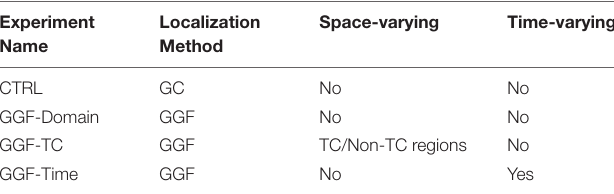
TABLE 1 | Details of localization parameters for the assimilation